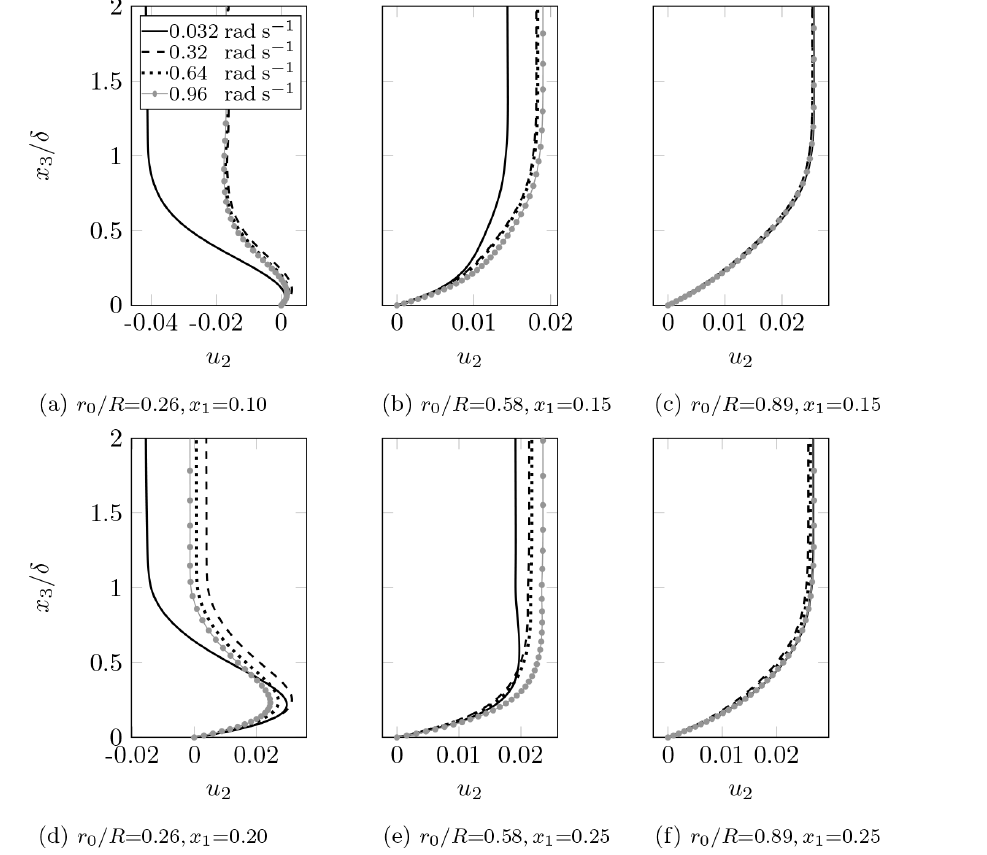
Figure 8. Spanwise velocity profiles for Geometry 1 for several rotation